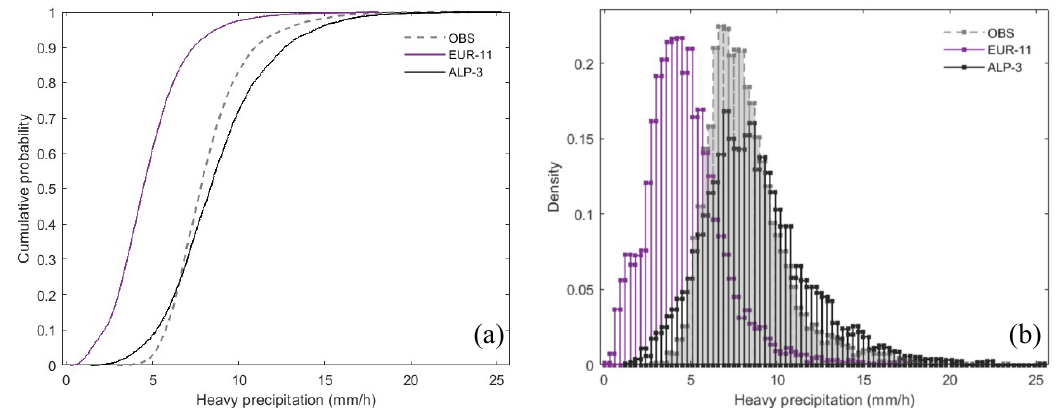
Figure 5. The empirical cumulative distribution functions ( a ) and probability density functions, ( b ) related to heavy precipitation 99.9p from hourly data. The observations are filled with a grey